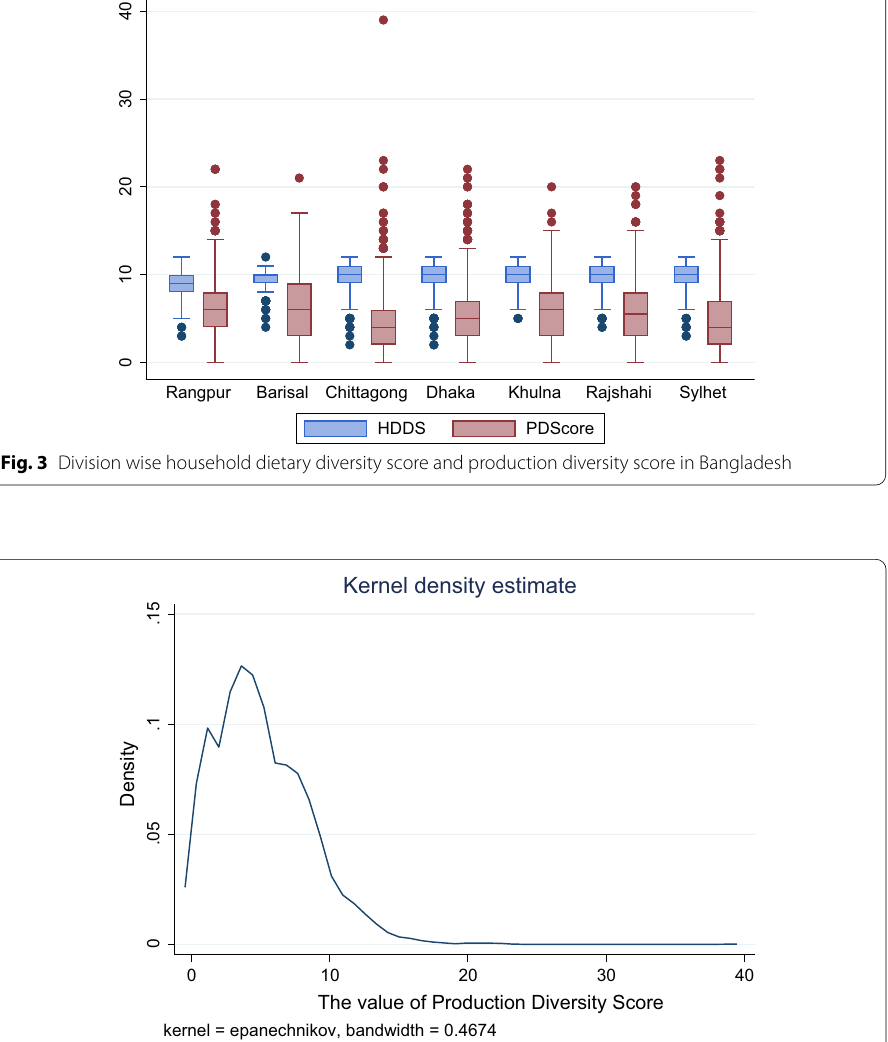
Fig. 4 Kernel density of production diversity score in Bangladesh